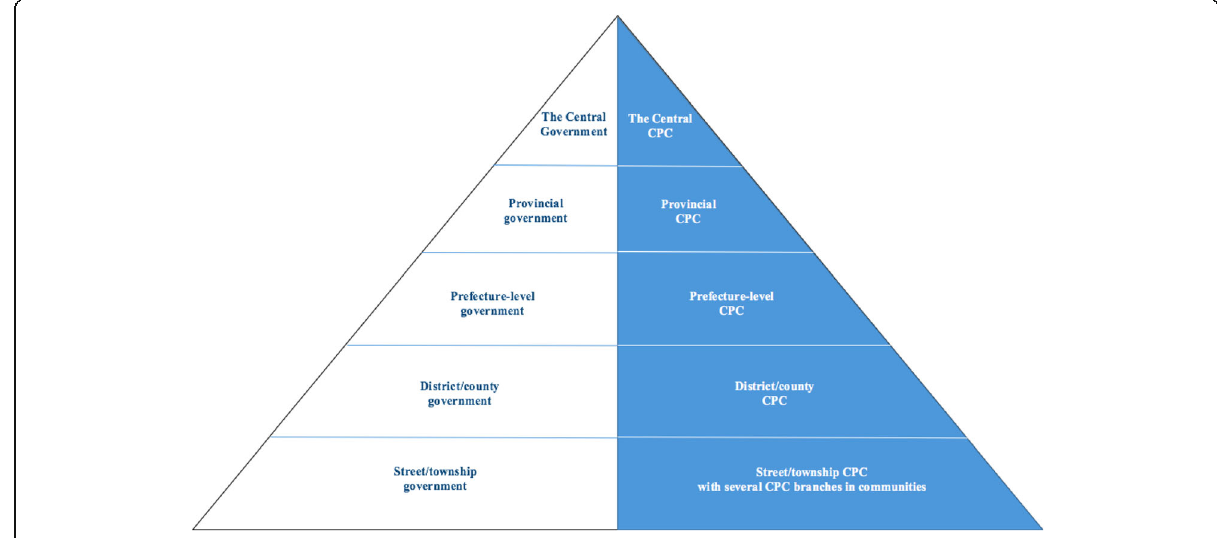
Fig. 1 Two parallel administrative